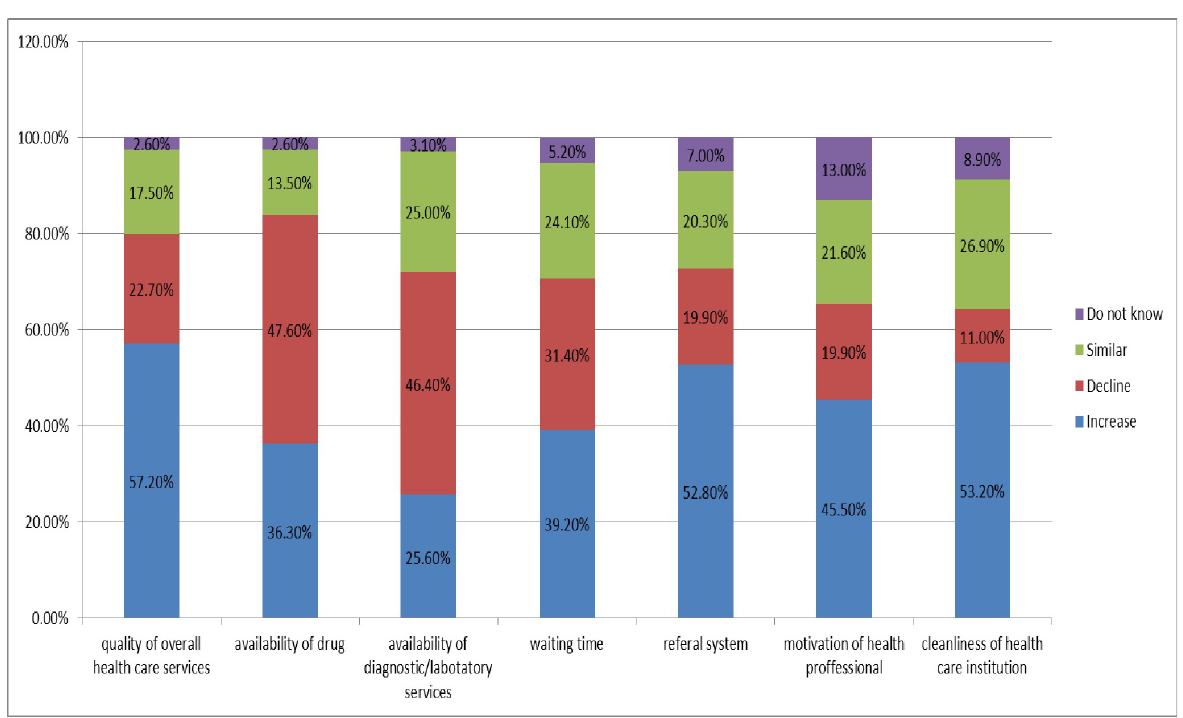
Fig 1. Impacts of CBHI on quality of service (perceived) at contracted health facilities among household in manna District Jimma, South West, Ethiopia, 2020.